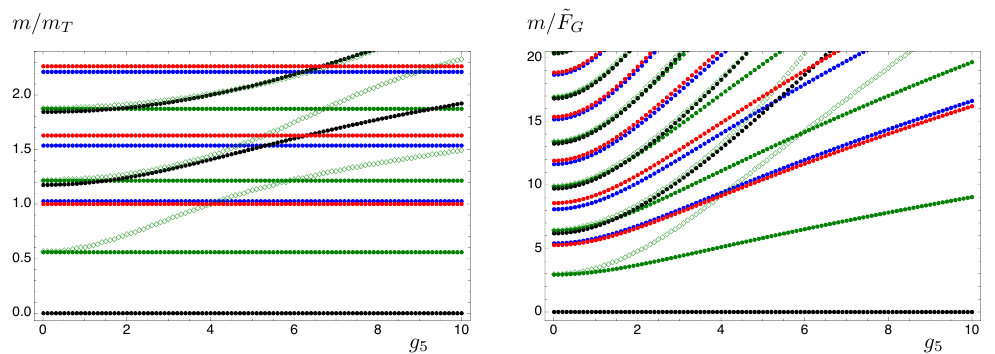
Figure 4 . Example A. Spectrum as a function of g 5 for ∆ = 3 , ˜ σ = 2 , r 1 = 0 , r 2 = 8 . The left panel is normalized to the mass m of the lightest tensor, while the right panel is normalized to T the decay constant ˜ F = F . The colour coding is: scalar (blue), tensor (red), pseudoscalar G G /N C (black), vector (green), axial-vector (green diamonds). Since ∆ > 2 , there is also a massless dilaton in the spectrum, as can be seen from figure 3; due to the numerical resolution deployed only the Goldstone is shown in the present two